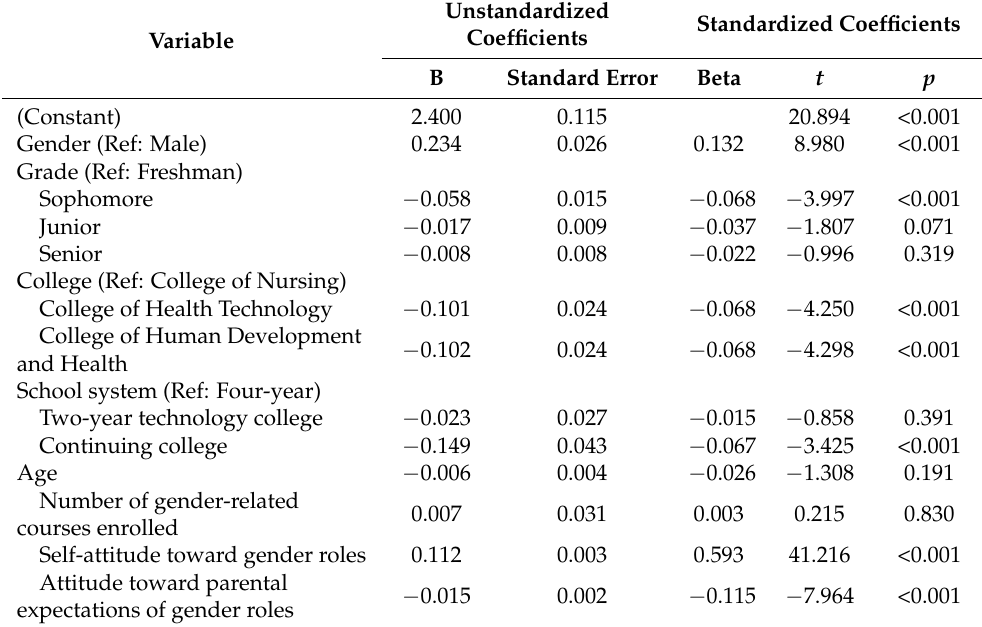
Table 5. The multiple regression analysis of the attitudes towards GE in employment (n =